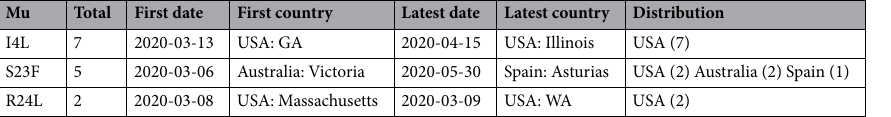
Table 9. Gene ORF10—nonsynonymous mutations occurring in 2 or more